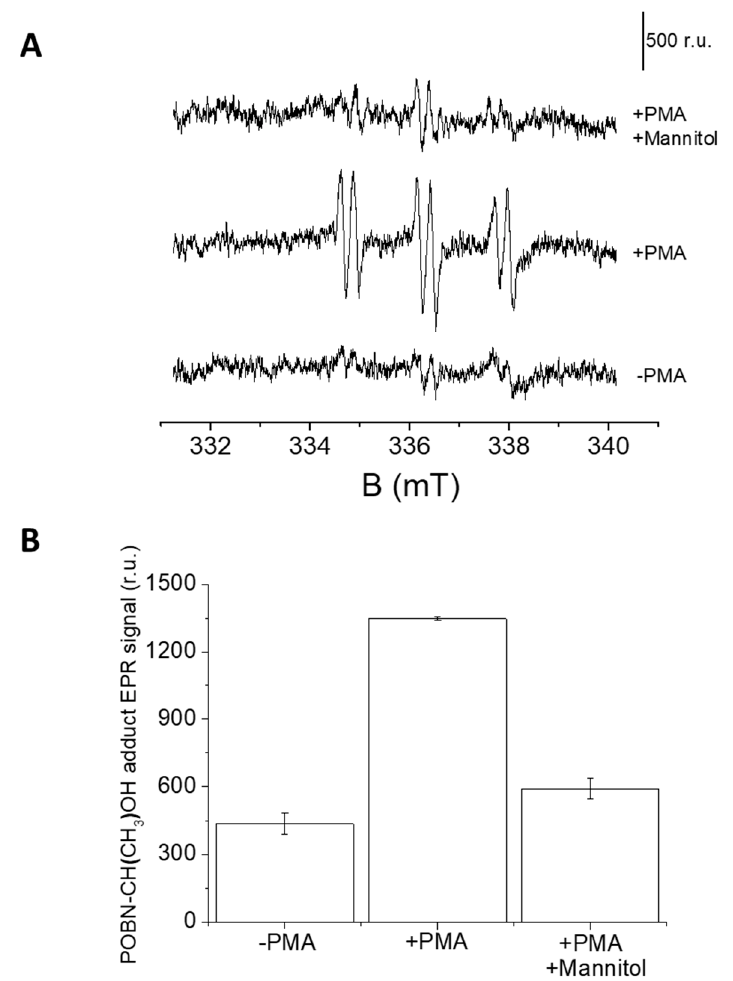
Figure 7. ( A ) PMA induced POBN-CH(CH 3 )-OH adduct EPR spectra. U-937 cells were incubated with 50 mM POBN in the absence (lower trace) or presence of 50 µ M PMA (middle trace) and 50 µ M PMA + 5 mM mannitol (upper trace). Vertical bar represents 500 relative units. ( B ) Bar chart representing values +/- SD of EPR spectra measurements ( n = 3).